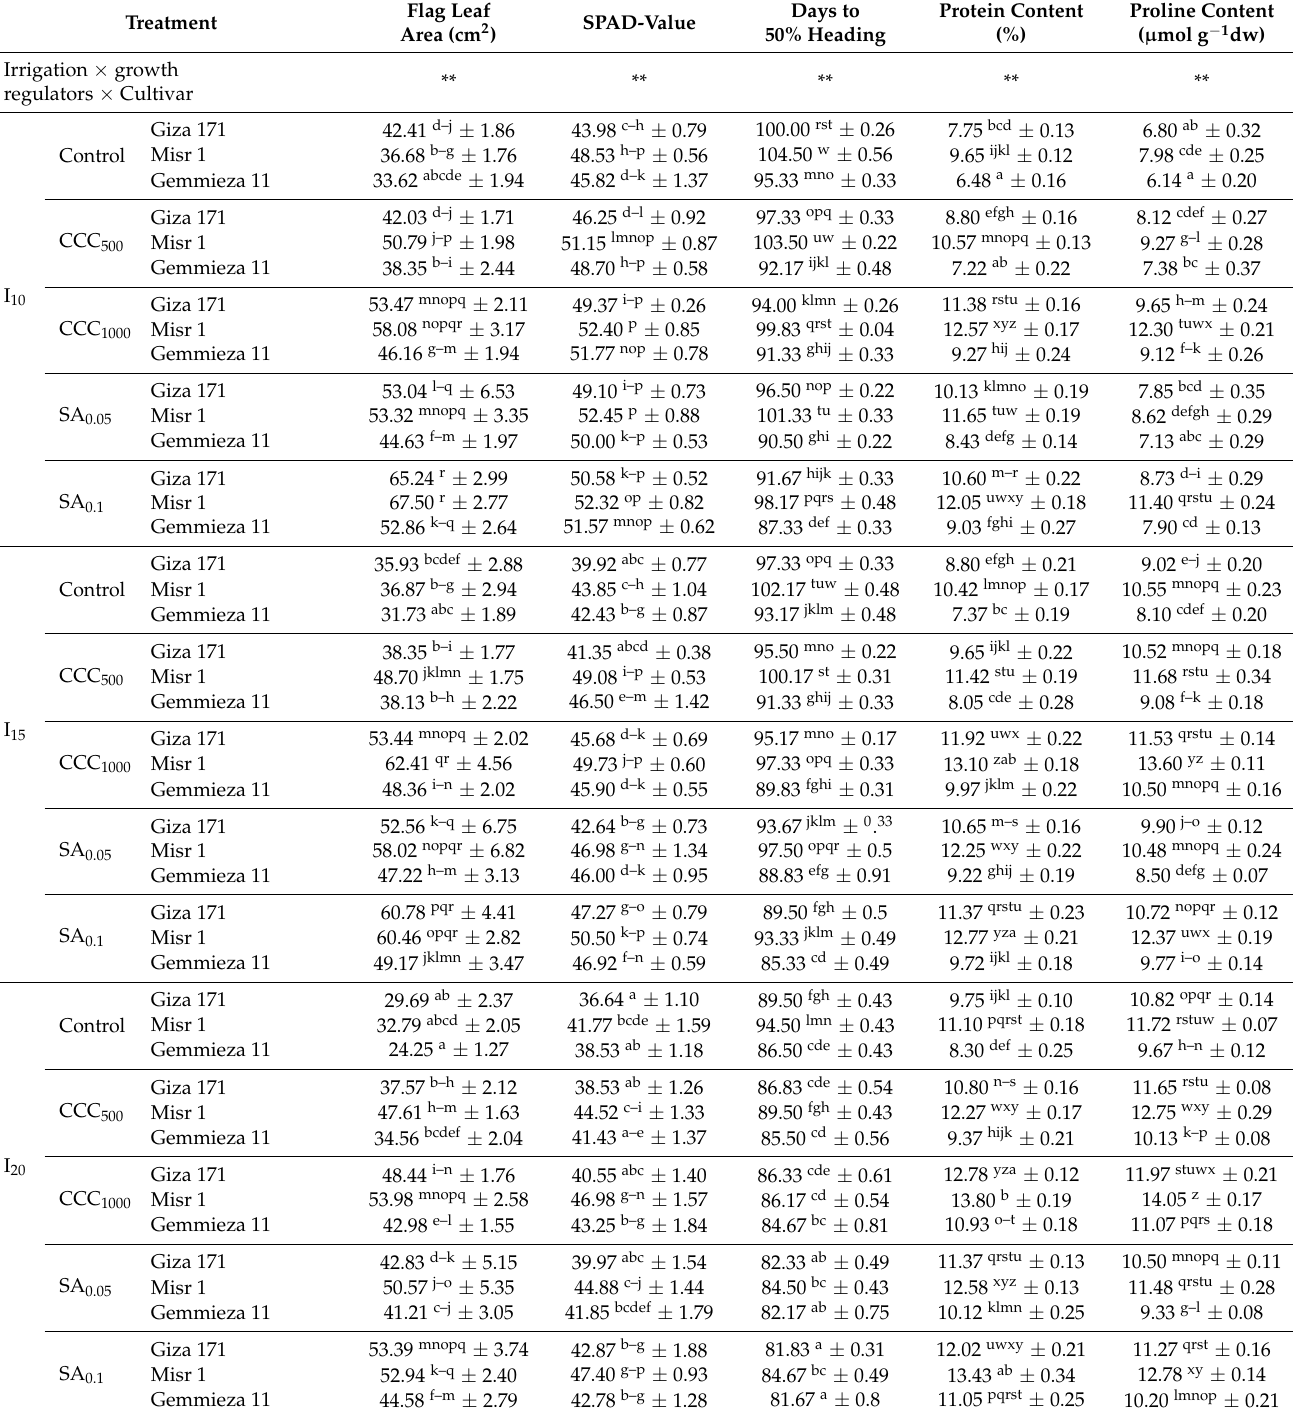
Table 5. Second-order interaction between irrigation intervals, growth regulators and wheat cultivars on flag leaf area (cm 2 ), SPAD-value, days to 50% heading, protein content (%) and proline content ( µ mol g − 1 dw) of wheat in (combined two seasons) (mean ±